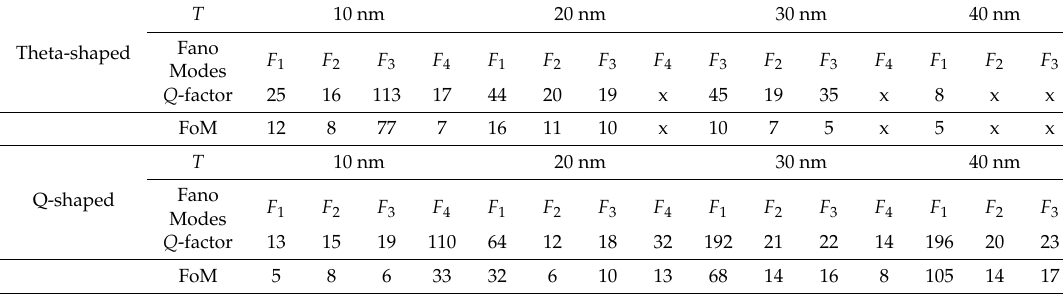
Table 3. Q ‐ factor and FoM values around Fano resonances